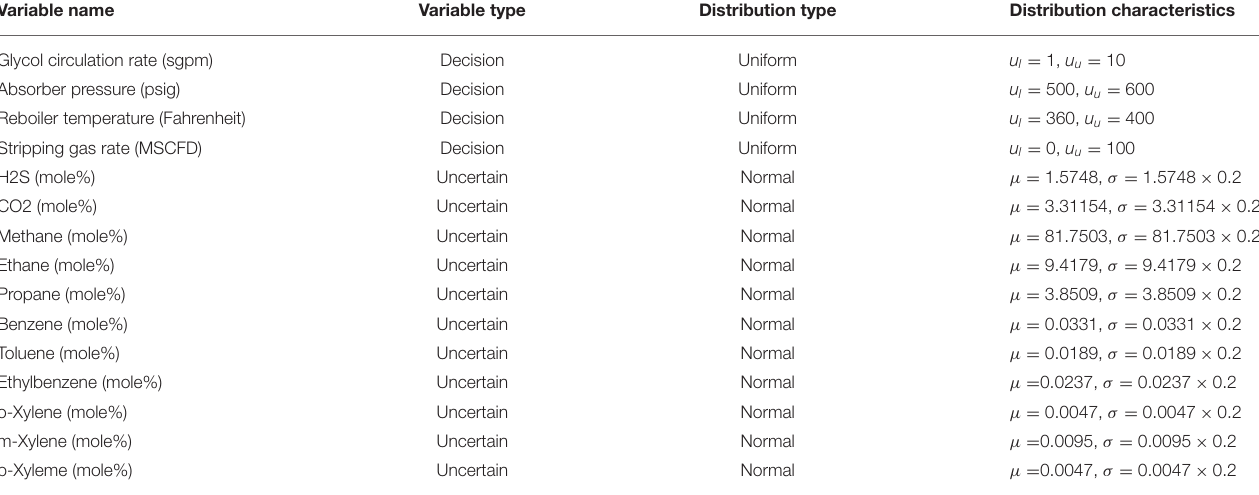
TABLE 2 | Range of the process variables as used for